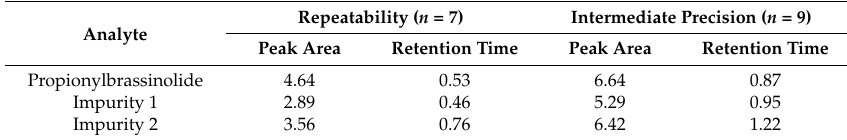
Table 2. Determination of method precision under repeatability (intraday) and intermediate precision (interday) conditions reported as RSD (%) of peak area and retention time.